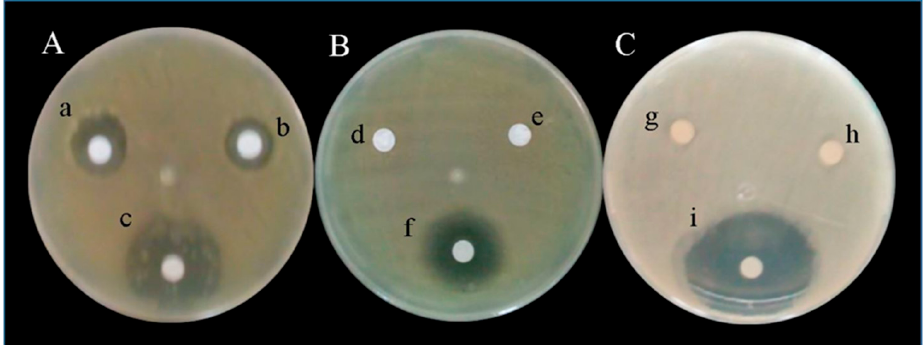
Figure 5. ( A ) Inhibition zone (mm) of X. campestris pv. campestris by the effect of cinnabarin in PDA+C at 7 (a), 14 (b) and 21 (c) days; ( B ) negative controls (d and e) and PDA+P at 21 days (f); ( C ) negative controls (g and h) and positive control (i) at 48 h.